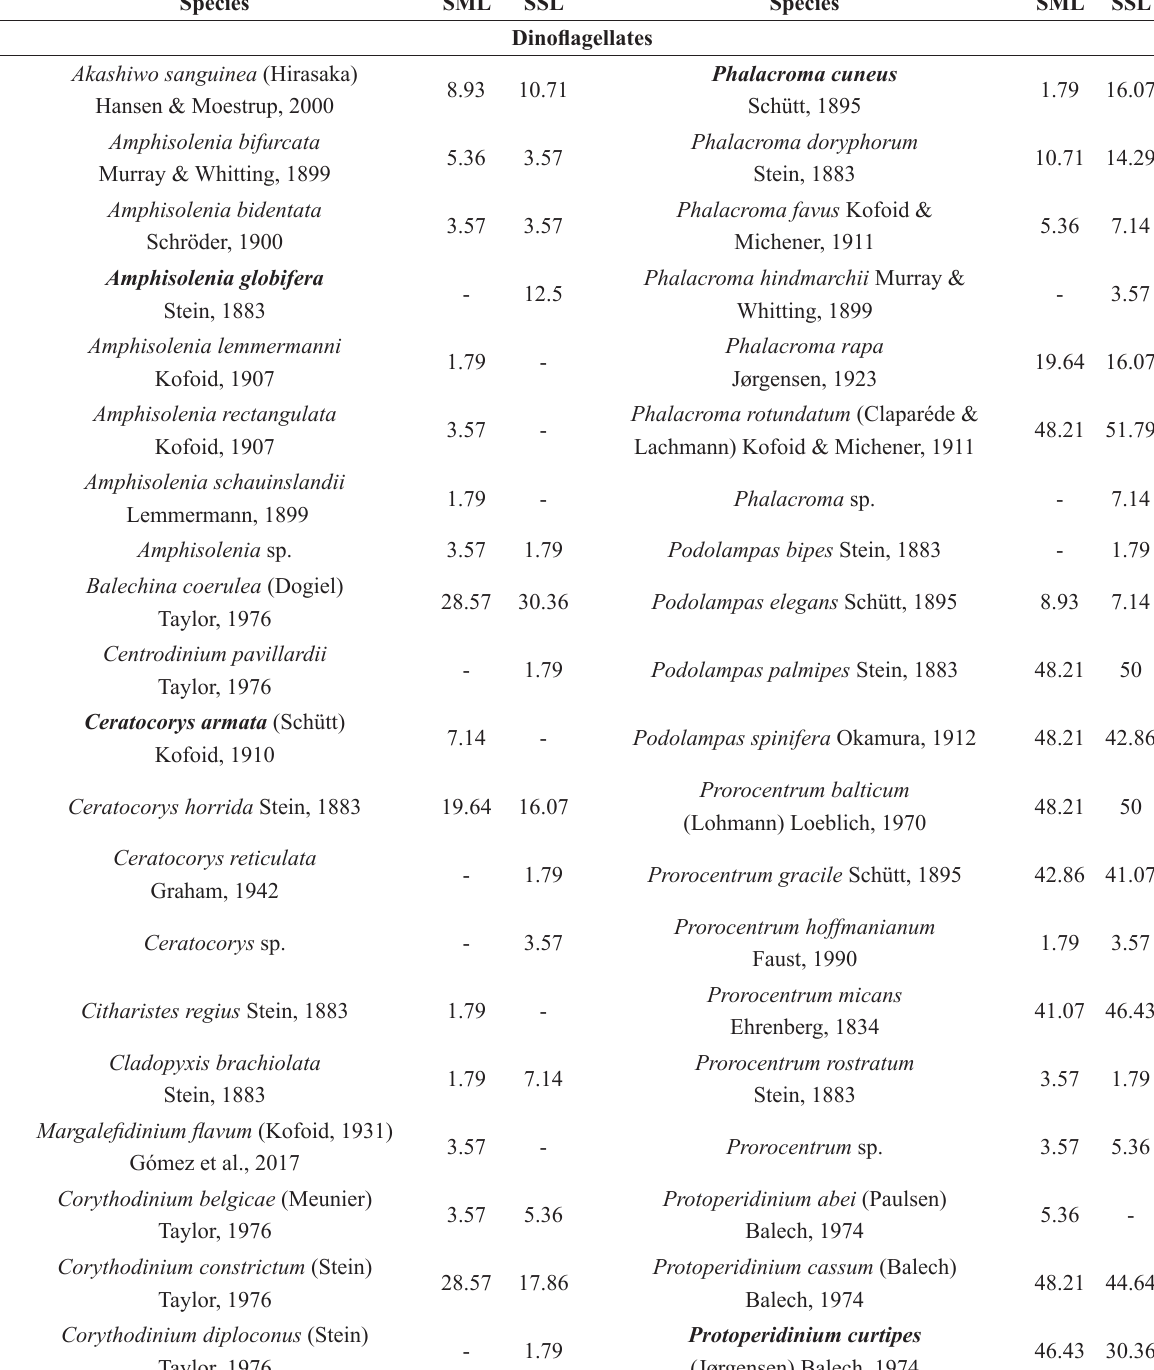
List of identified species found in the surface mixed layer (SML) and subsurface layer (SSL) around the ASPSP. Species in bold were classified as ecological indicators by the IndVal analysis. The numbers are frequency of occurrence in the samples